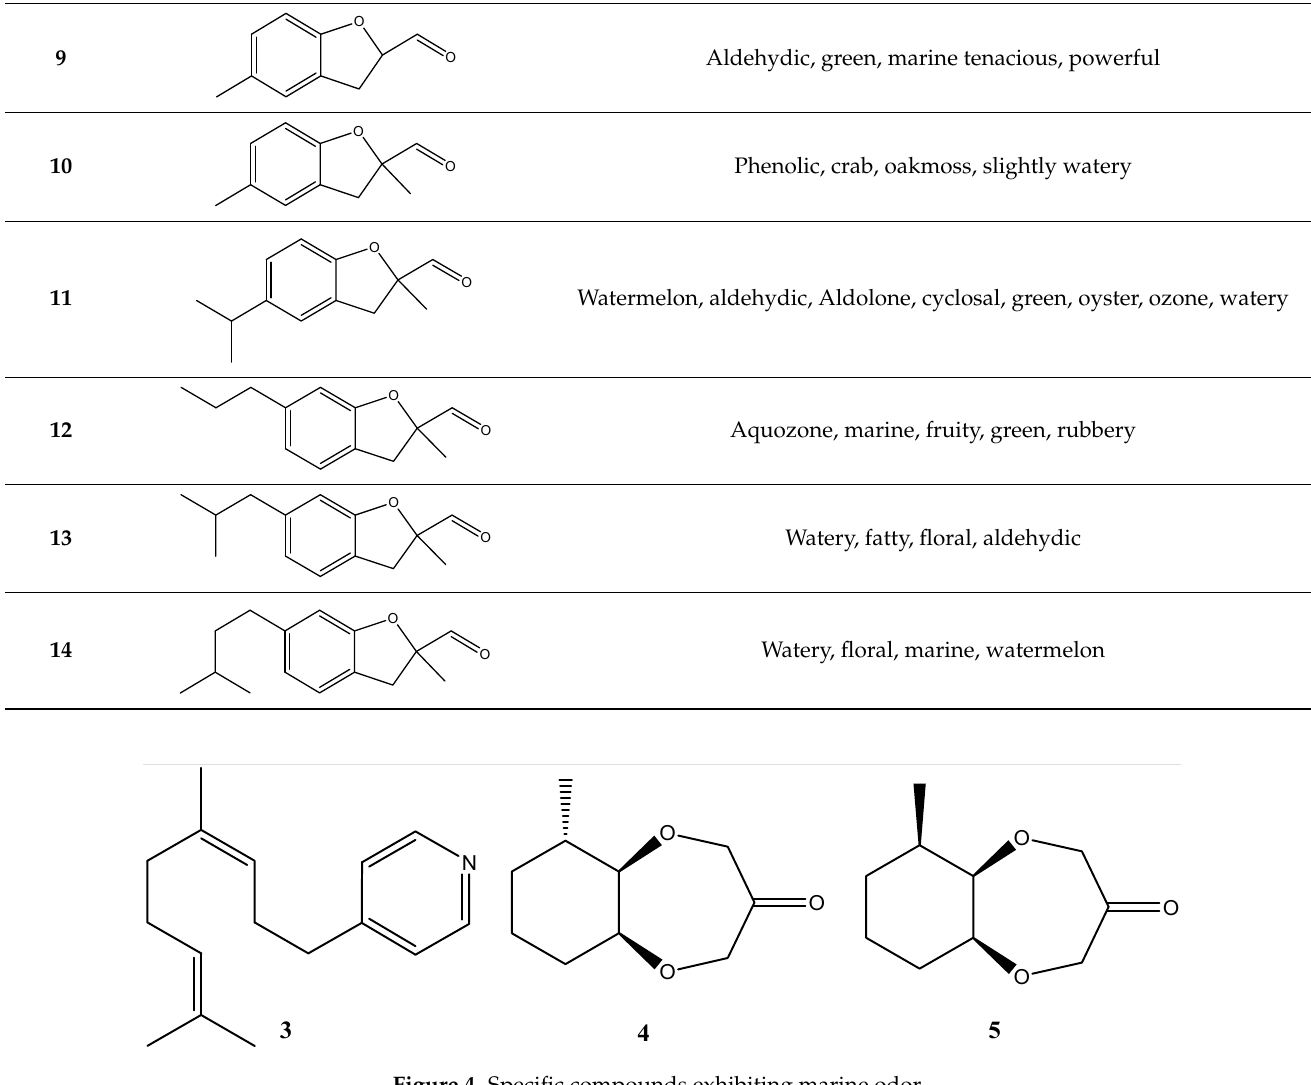
Figure 4. Specific compounds exhibiting marine odor. Table 2. Olfactory profile of five-membered ring compounds.